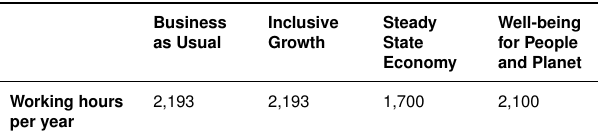
Table 5. Annual working hours per employee in different scenarios.